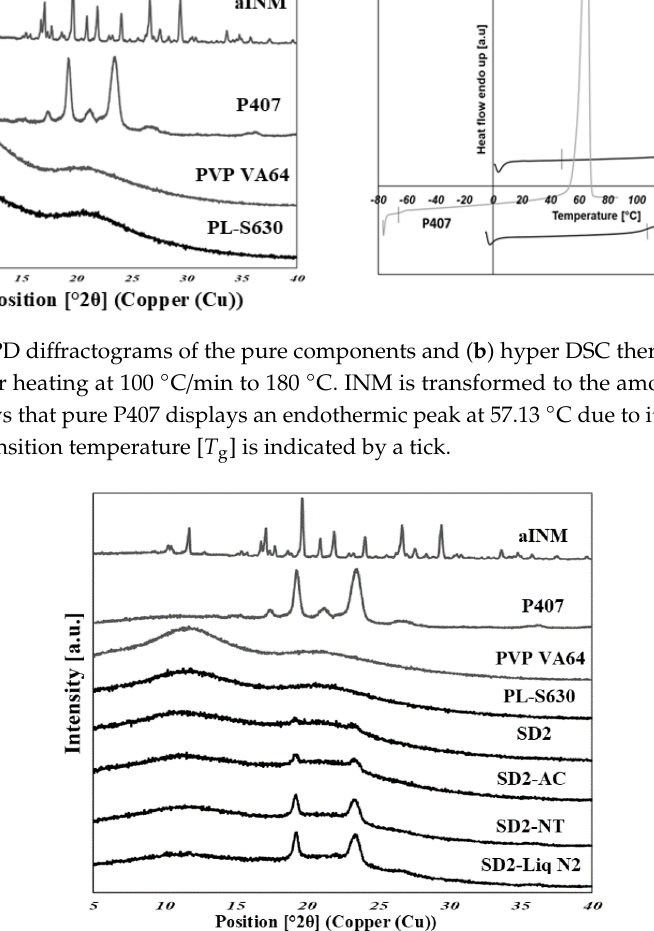
Figure 7. XRPD diffractograms of SD formulations and XRPD diffractograms of the SD